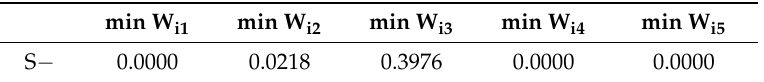
Table 23. Table of nadir